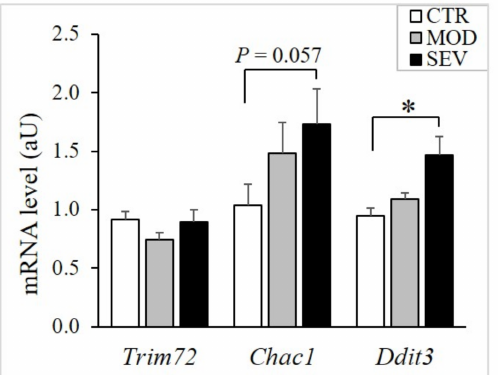
Figure 5. Muscle mRNA levels of stress genes in mice fed Mg 2+ -deficient diet. TaqMan low-density array (TLDA) was used to measure mRNA levels in gastrocnemius muscle of mice fed either a control (CTR; white bars), a mildly (MOD; grey bars), or a severely Mg 2+ -deficient diet (SEV; black bars). * indicates significant difference ( P < 0.05) from the CTR group.